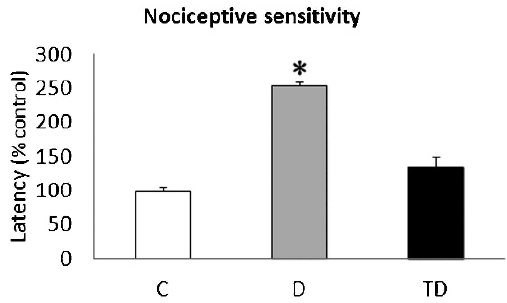
Figure 1 - Nociceptive sensitivity: the latency to tail deflection on the tail-flick apparatus for the C, D and TD groups. ANOVA followed by Bonferroni’s post hoc test. *corresponds to p , 0.001 compared with the C and TD groups.